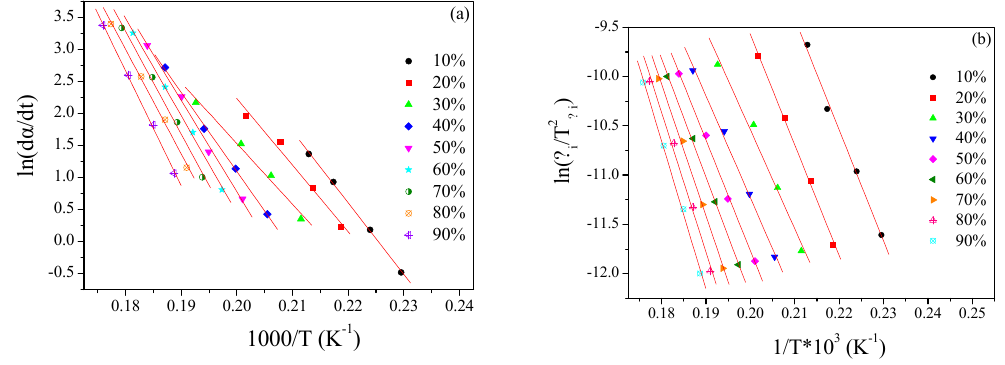
Figure 4. Representative plots of ln(d α /d t ) vs. 1/ T based on the differential isoconversional method of Friedman ( a ), and ln( β i / T 2 α ,i ) vs. 1/ T according to the integral isoconversional method of Coats and Redfern ( b ) for the PMMA + 1 wt % Cloisite 15A nanocomposite.